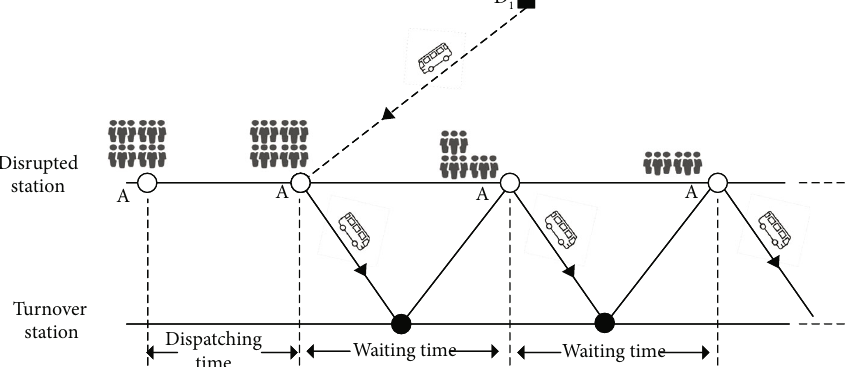
Figure 3: Passengers ’ waiting time in the bus bridging service.